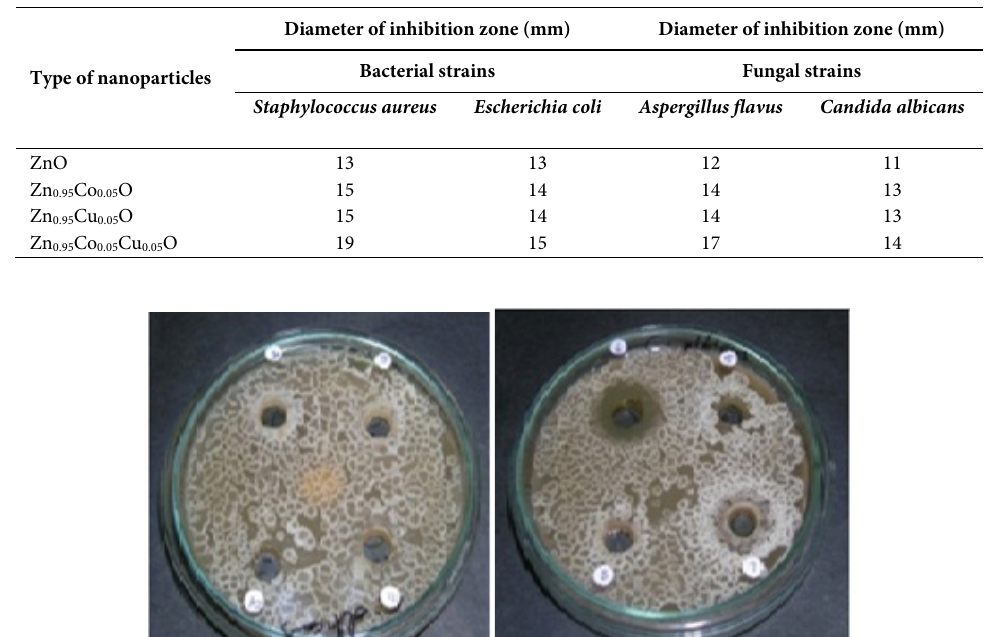
Table. 3 Antimicrobial activity of ZnO, Cu-ZnO, Co-ZnO and (Co, Cu)/ ZnO NPs against pathogenic bacterial and fungal strains